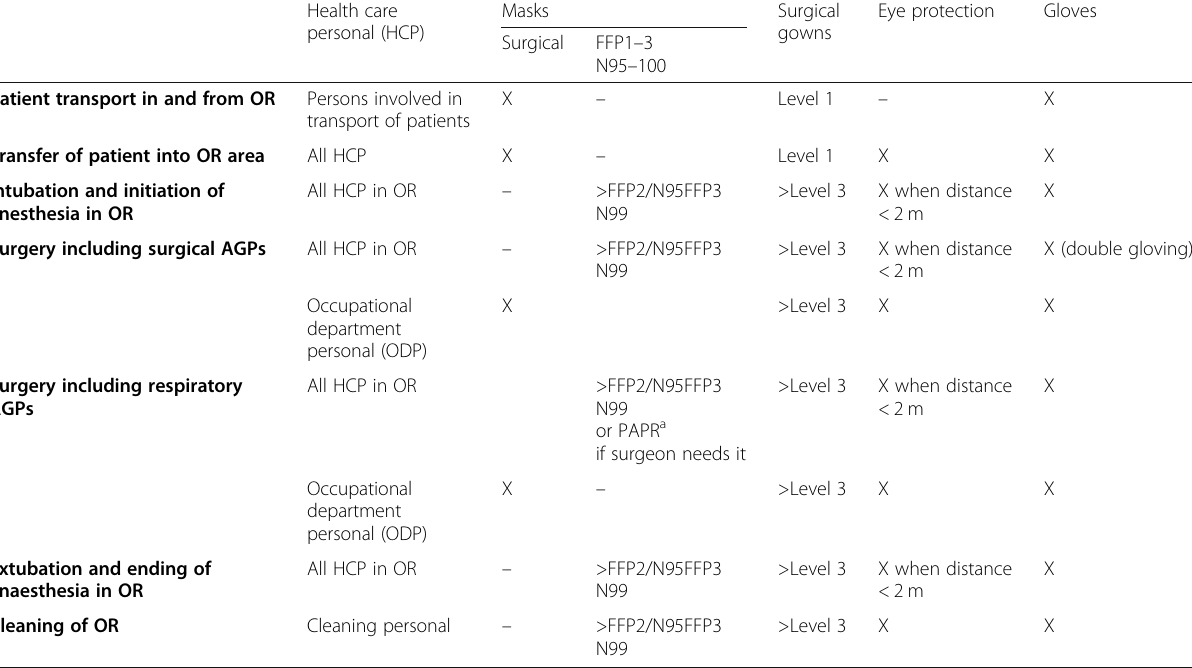
Table 4 Balanced recommendations for PPE in operating area for COVID-19499 positive patients or suspected COVID-19 patients